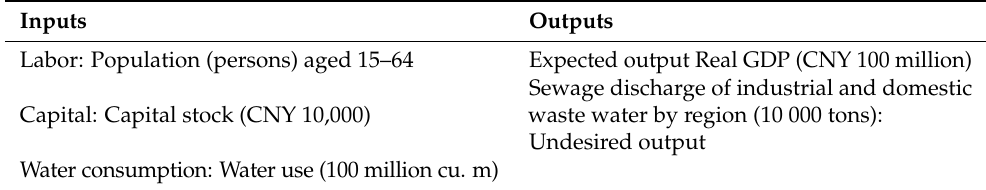
Table 1. Inputs and Outputs used for WUE and productivity change estimation.